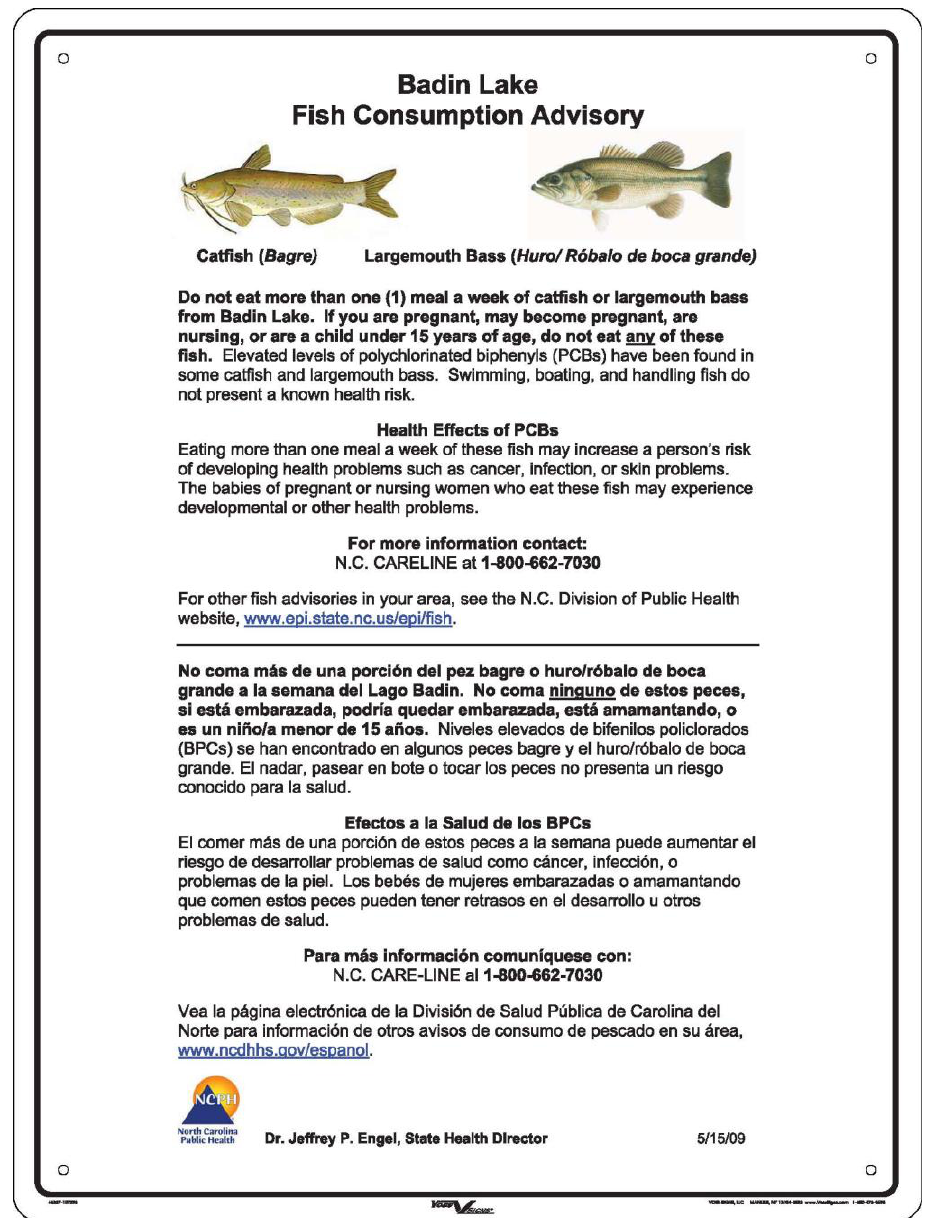
Figure 1. Informational sign designed by the North Carolina Division of Public Health to communicate the fish consumption advisory at Badin Lake, NC, USA. (Courtesy of the North Carolina Department of Health and Human